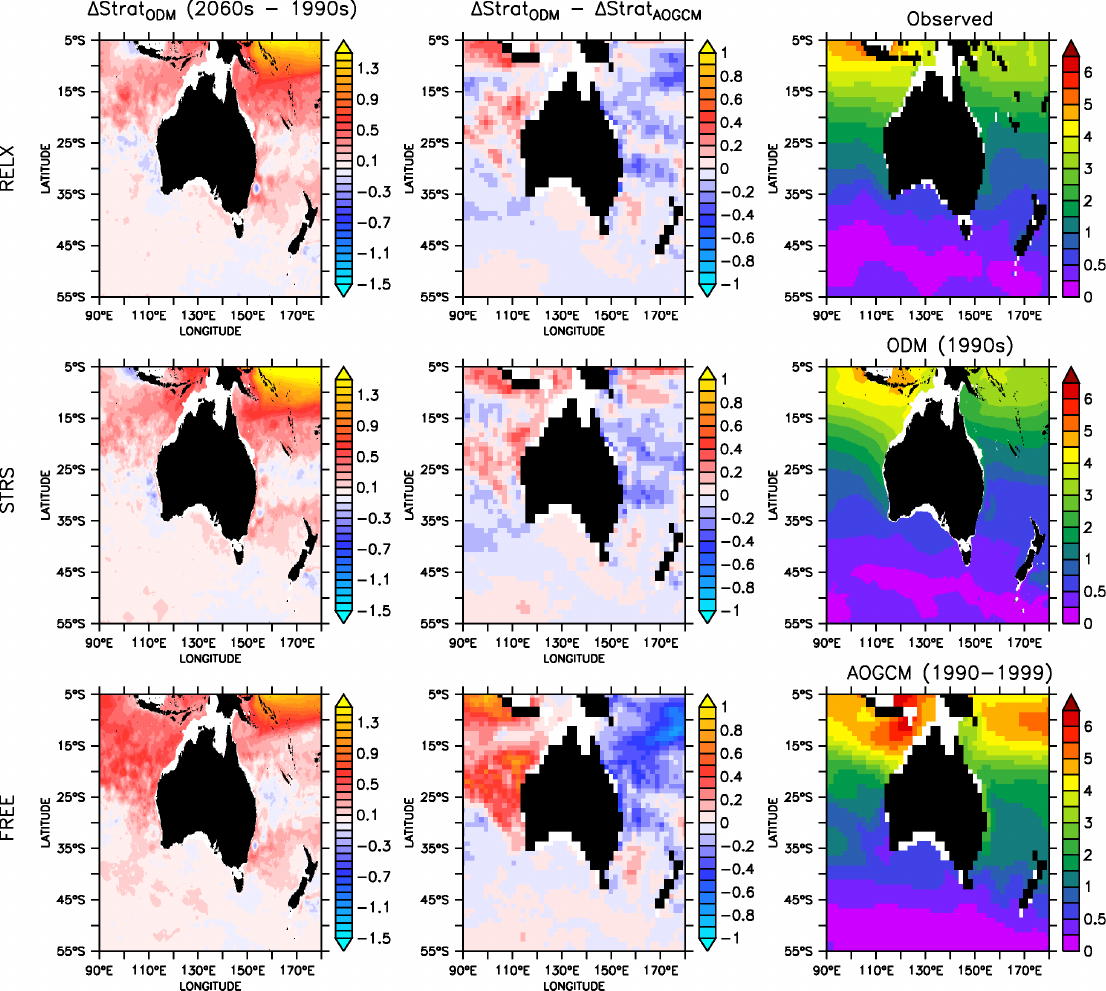
Fig. 12. Annual averages of: projected climate change in stratification from the ODM (left column, in kgm − 3 ), and differences in climate change for stratification (centre, kgm − 3 ). In these columns, the RELX experiment is shown along the top, STRS is in the middle, and FREE is at the bottom. The right column shows stratification for the 1990s in the ODM and AOGCM compared to observations (Levitus, 2002). Stratification is shown here as the difference in density of water at a depth of 200m and at the